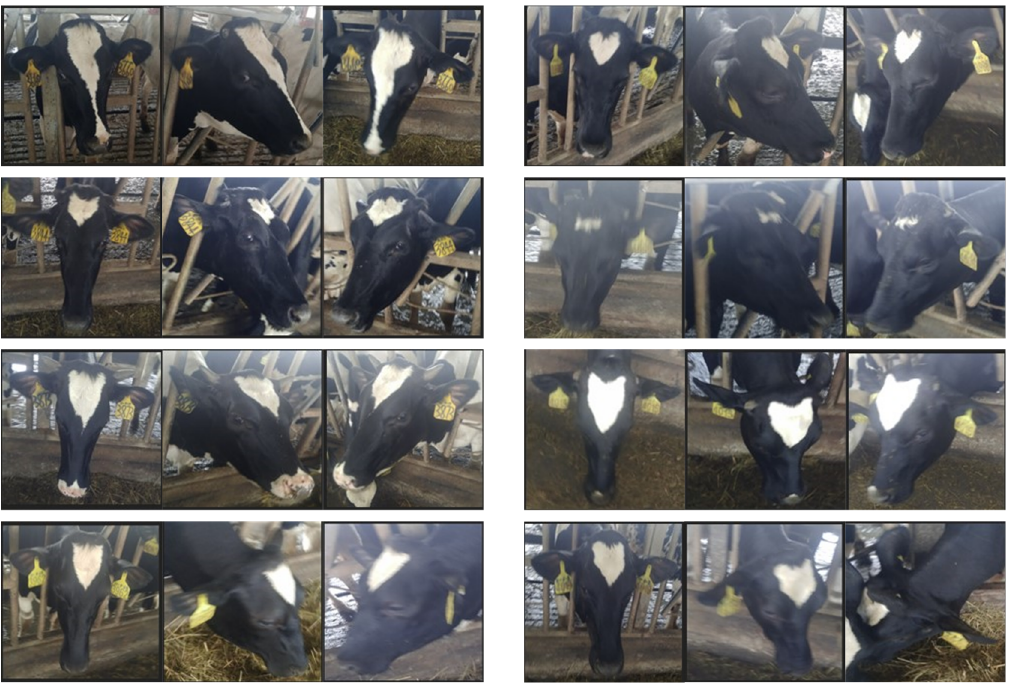
Figure 3. Comparisons of intra-class gap and inter-class gap in dataset. Three cow face images of the same cow are in a row.